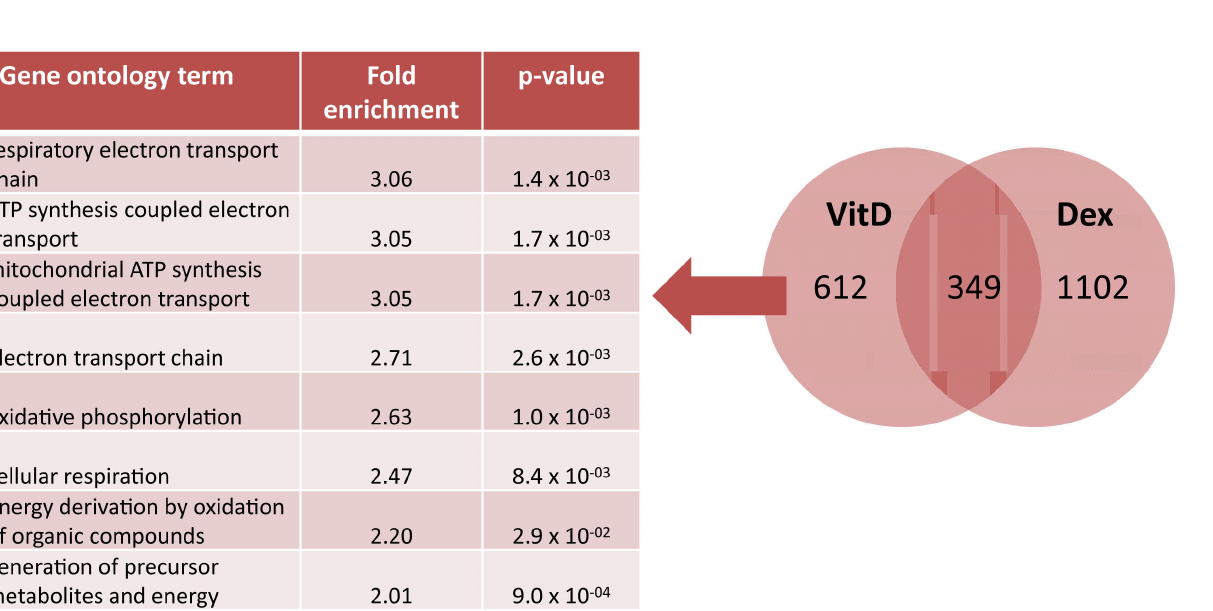
Figure 5. Intersection and significant gene set enrichment analysis of differentially expressed up-regulated genes in response to dexamethasone and vitamin D at 24 hours. Non-overlapping up-regulated genes unique to vitamin D treatment were significantly enriched for terms involved in metabolism and cellular